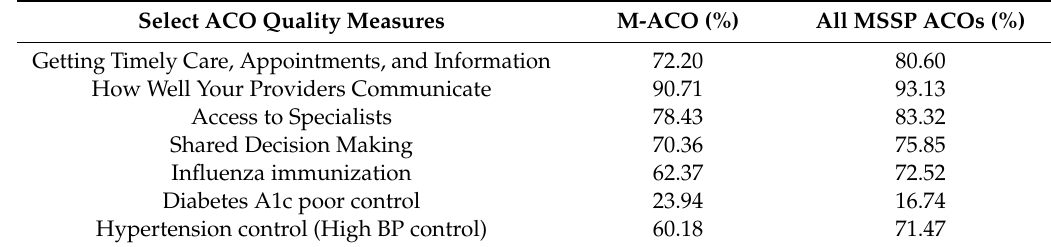
Table 4. Select ACO Quality Measures as publicly reported by CMS.